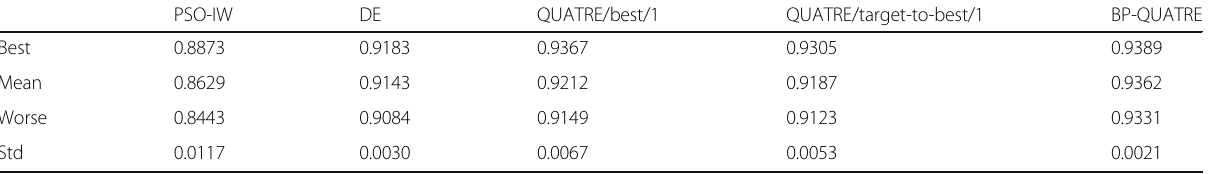
Table 4 Performance for competing algorithms in the dynamic deployment of WSN PSO-IW DE QUATRE/best/1